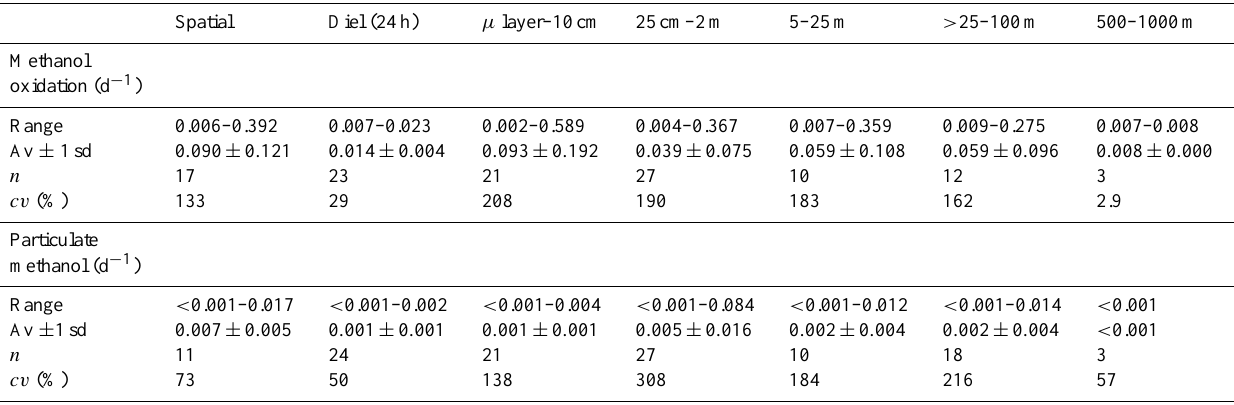
Table 3. Summary of microbial methanol uptake and